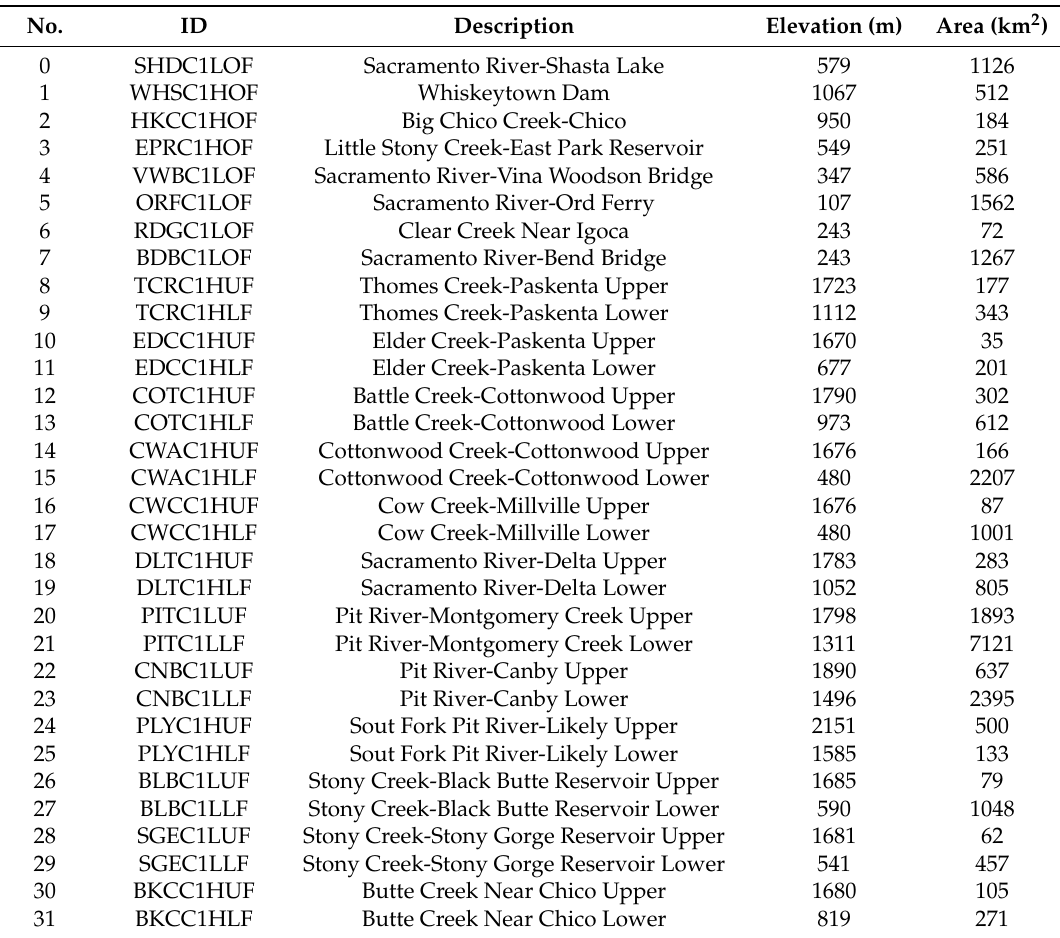
Figure A1. Study basins of ( a ) Upper Sacramento Group; ( b ) Feather Yuba Group; ( c ) American Group; ( d ) North San Joaquin Group; ( e ) San Joaquin Group and ( f ) Tulare Group. Table A1. Study basins in the Upper Sacramento Group.